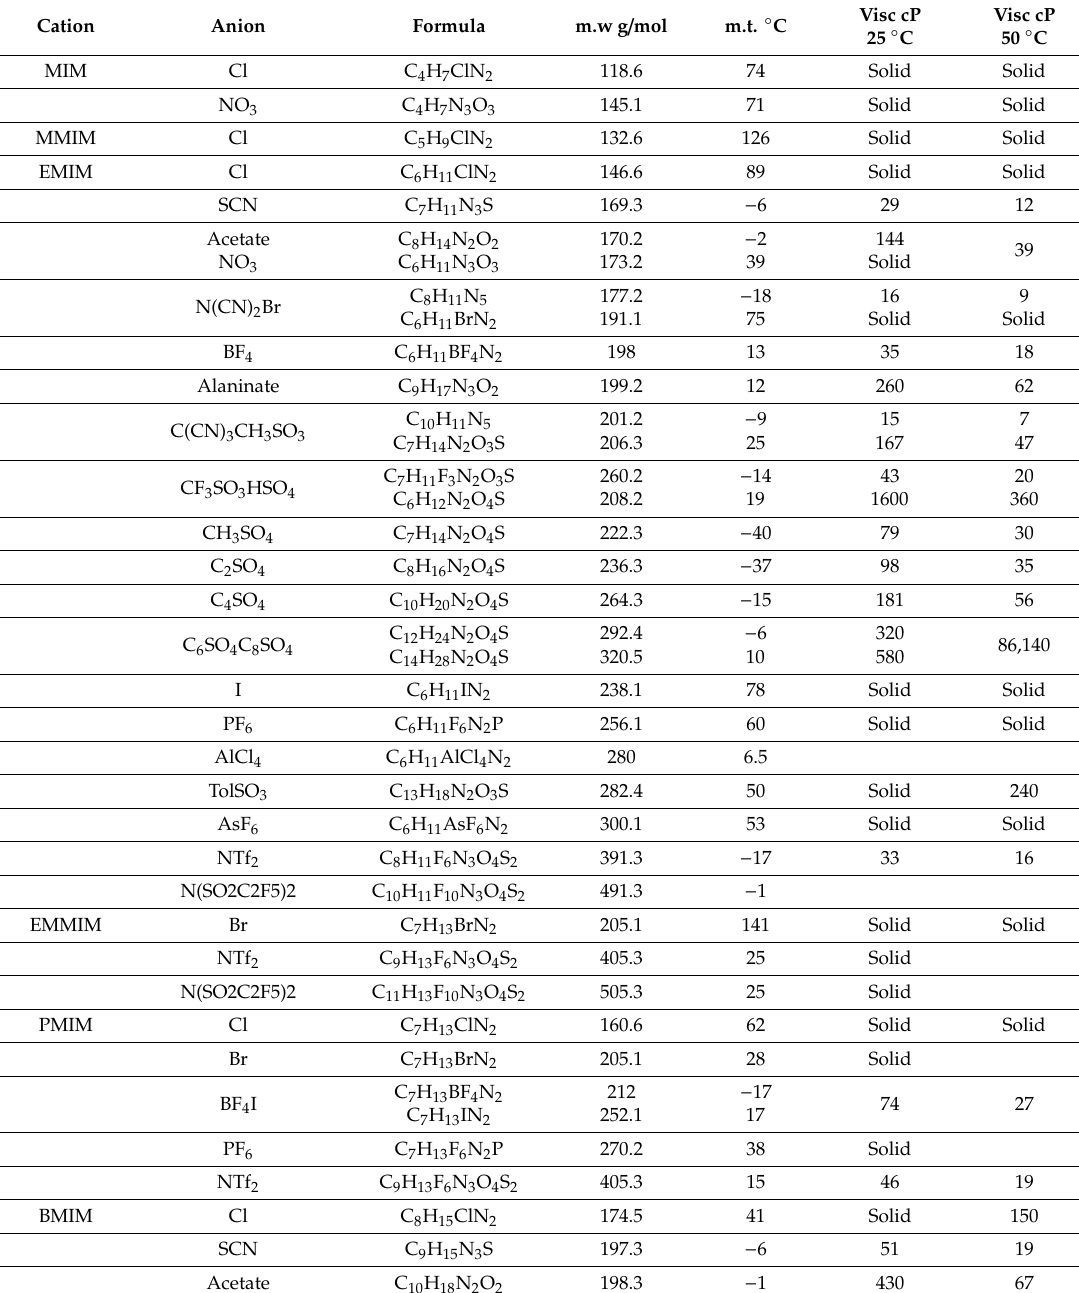
Table5. Physicochemical properties of selected methylimidazolium ionic liquids sorted by the cation [39].